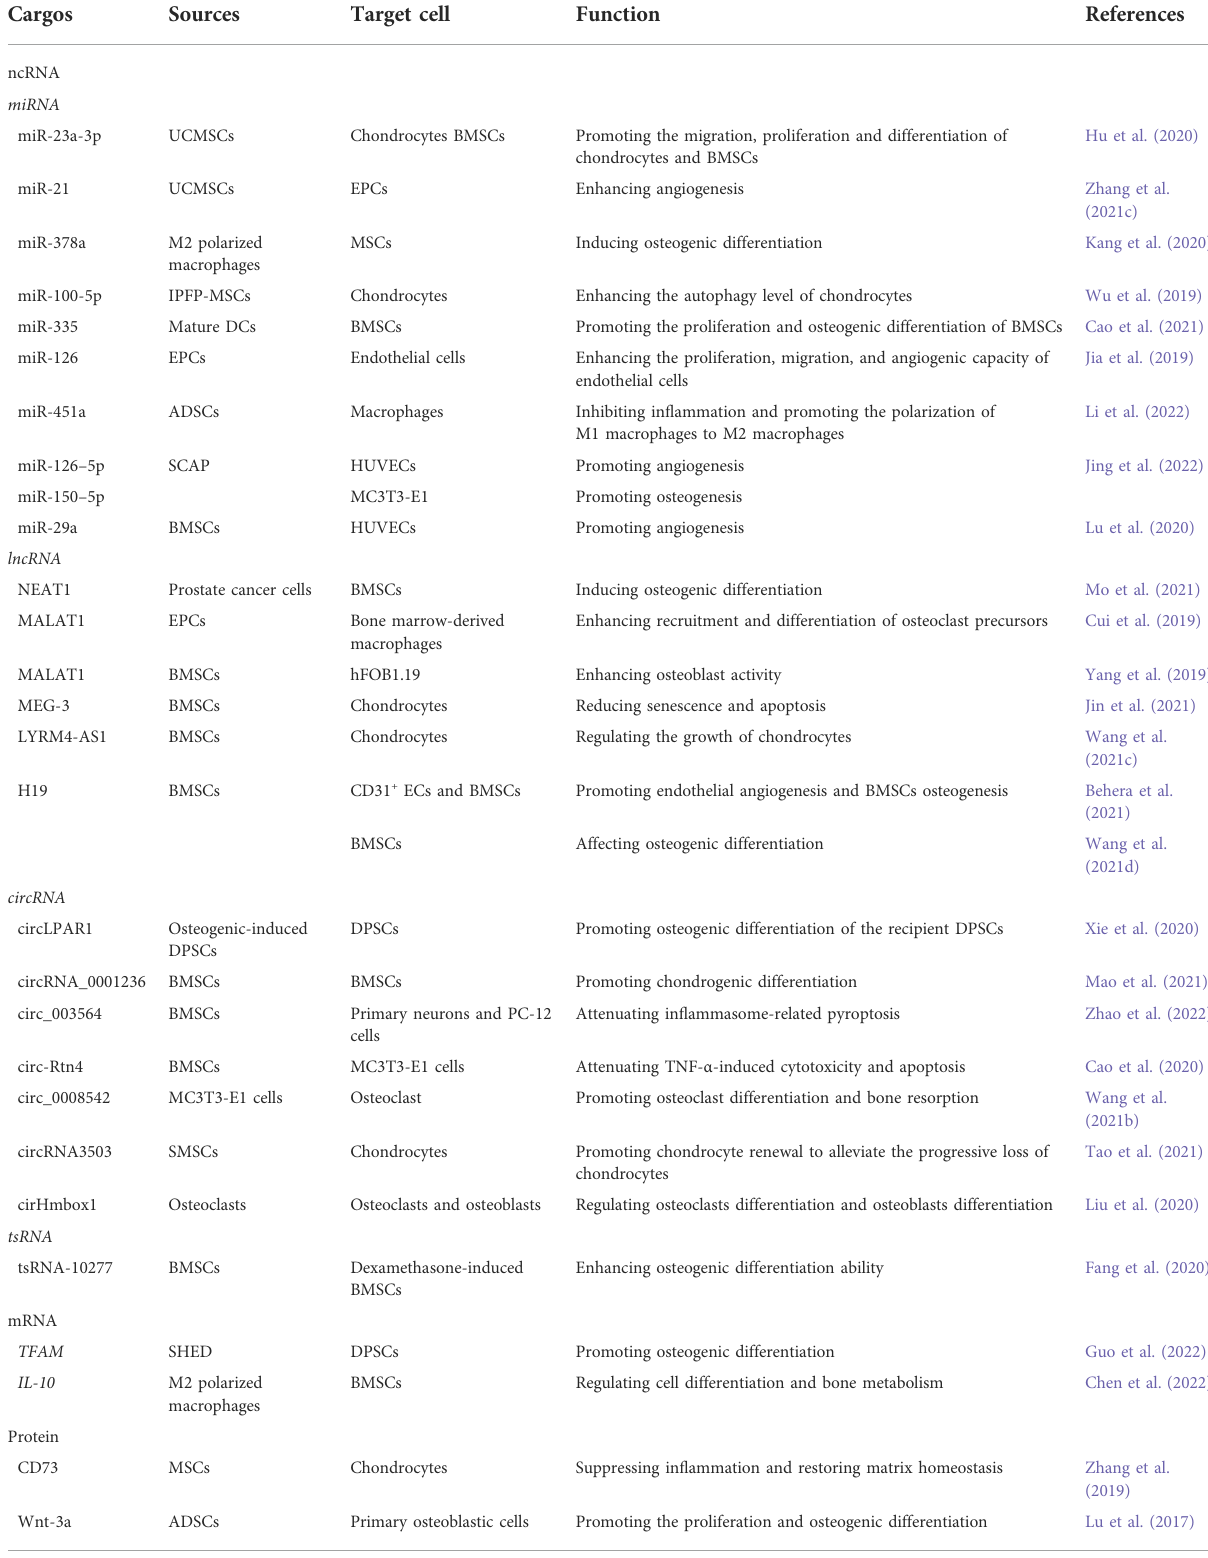
TABLE 1 The exosomal cargos involved in bone